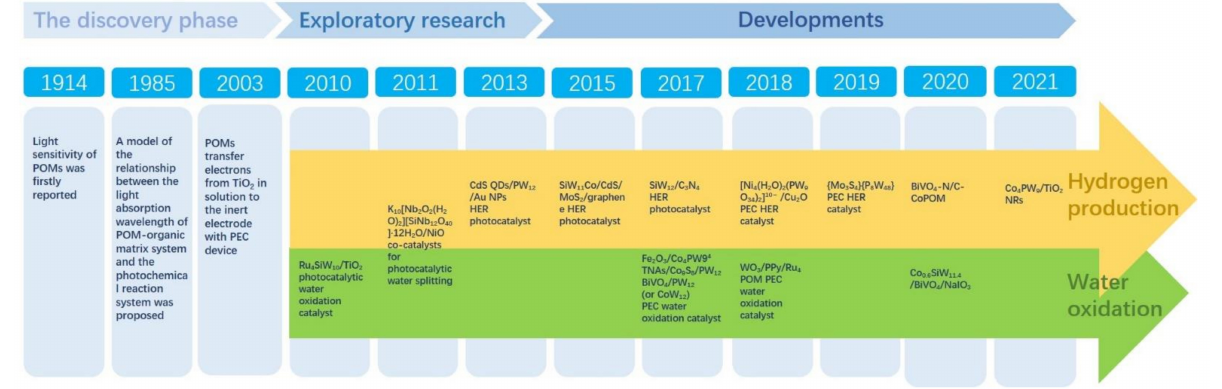
water splitting